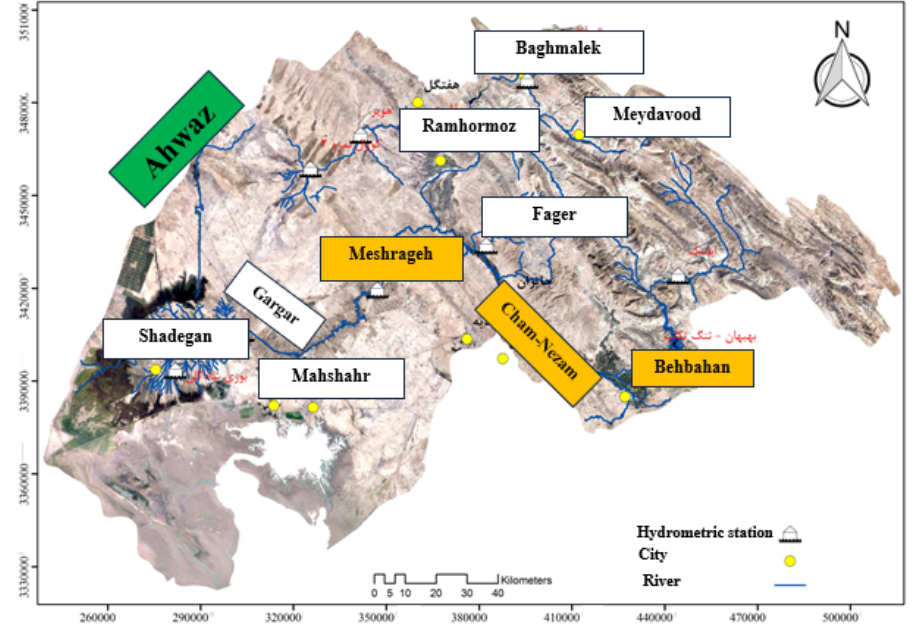
Figure 7. Location of hydrometric stations in the Maroon and Jarahi basin. Table 5. Sources of inlet and point-source pollutants for the Maroon and Jarahi Rivers.